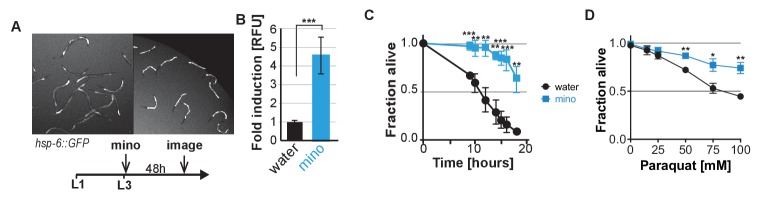
Despite inhibiting the UPRmt and the heat shock response in adults, minocycline activates the UPRmt in larvae and protects from stress.(A and B) Fluorescence image and experimental timeline (A) and quantification (B) for hsp-6p::GFP induction by minocycline added to L3 larvae. While minocycline suppressed GFP induction of all stress reporters tested in adults, it activates the hsp-6p::GFP in larvae. Data are represented as mean ±S.D. Significance determined by the Mann-Whitney t-test. (C) Survival as a function of time in hours for water- or 100 μM minocycline-treated wild-type N2 C. elegans subjected to a continuous heat shock of 35°C. Data are represented as mean ±S.E.M. Significance determined by the Mann-Whitney t-test at each time point. Total of three independent experiments. (D) Survival of water- or 100 μM minocycline-treated wild-type N2 C. elegans 24 hr after addition of increasing concentrations of paraquat added on day 5. Data are represented as mean ±S.E.M. Significance determined by the Mann-Whitney t-test for each paraquat concentration. Total of three independent experiments. Asterisks indicate significance *<0.05, **<0.01, ***<0.001, n.s. not significant.